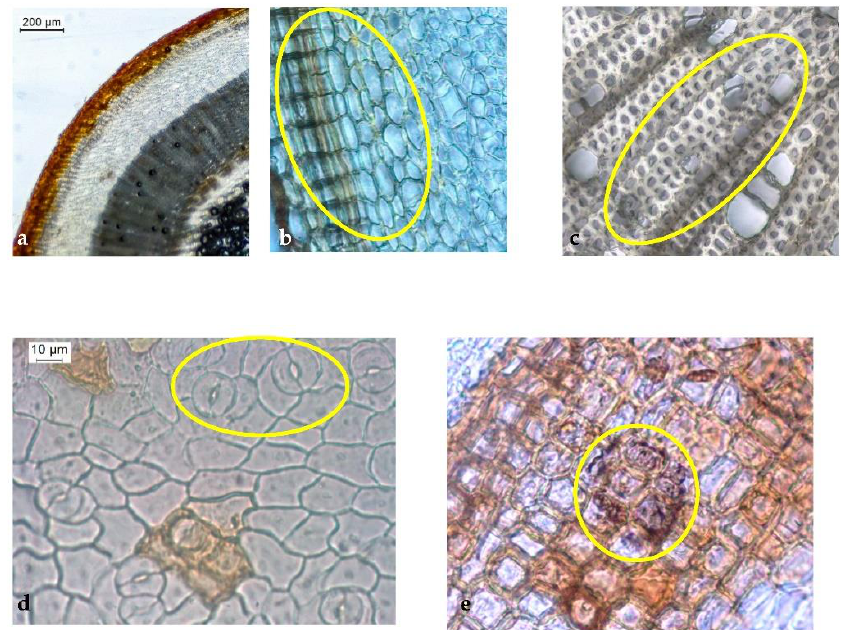
Figure 2. Light microscopy photographs of adult H. foliosum stem transverse section ( a – d ) and surface view ( e ). ( a ) General view showing four concentric rings with uneven distribution; ( b ) cortex region showing three to seven collenchymatous layers consisting of flattened cells and a type A secretory canal composed of four degenerated secretory cells and an evident lumen; ( c ) details of the xylem region associated with medullary rays; ( d ) epidermal strip detailing polyhedral phellem cells and paracytic stomata (oval selection); ( e ) details of brownish surface glands with a translucent interiors. Table 2. Light microscopic characteristics of H. foliosum stem.